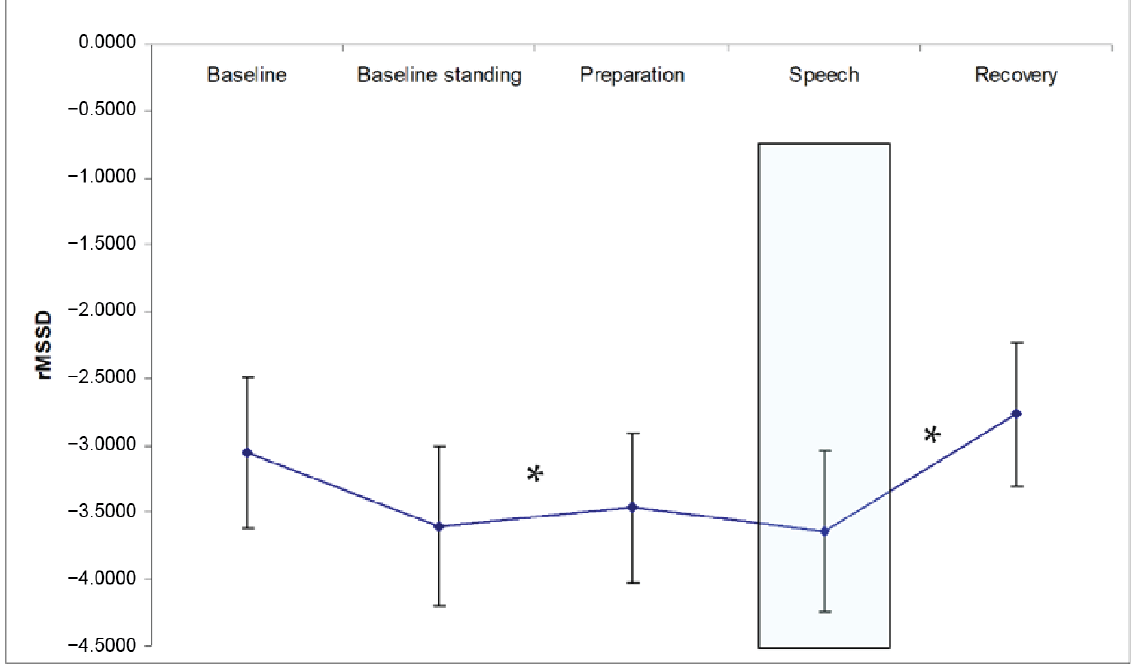
Figure 2. rMSSD (log-transformed) in response to the public speaking task. * p < 0.05 Helmert contrast (change).